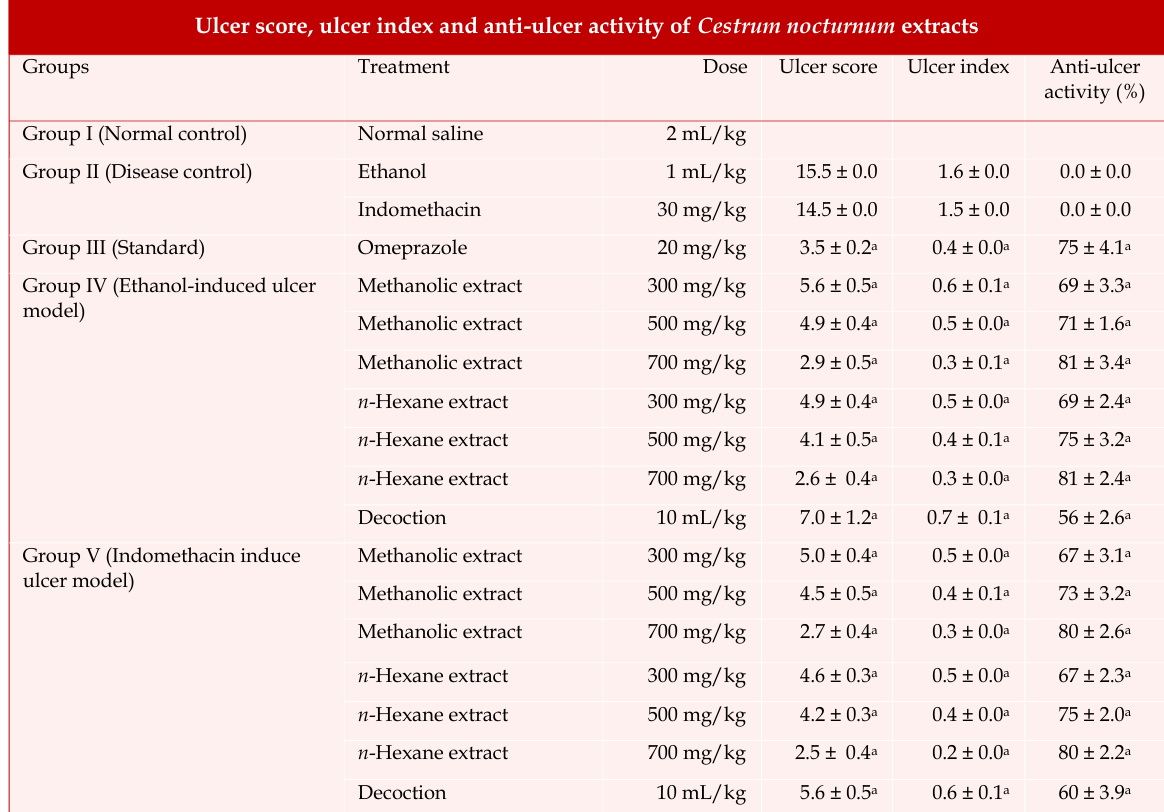
Ulcer score, ulcer index and anti-ulcer activity of Cestrum nocturnum extracts